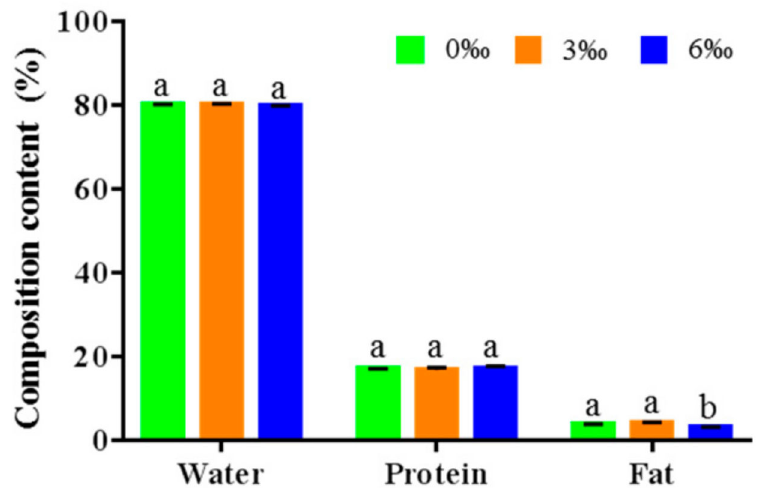
Figure 1. Composition of muscle in grass carp cultured at different salinities (0‰, 3‰, and 6‰). For the same parameter, different lowercase letters (a, b) indicate significant differences among different salinities ( p <